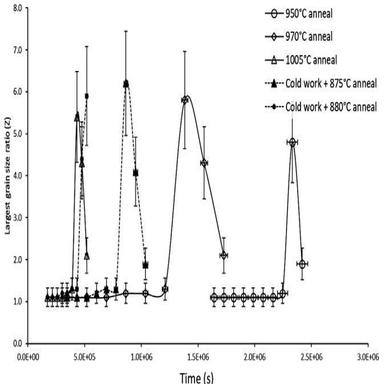
Dispersion parameter (Z) vs annealing time (t) for samples treated under various annealing conditions.